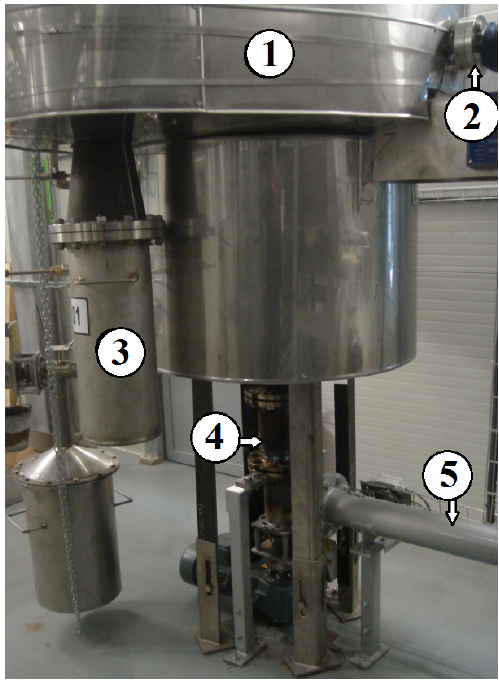
Figure 1. Reactor view: 1 —bottom of the reactor, 2 —steam pipe, 3 —ash collection, 4 —vertical screw conveyor, 5 —horizontal screw conveyor.